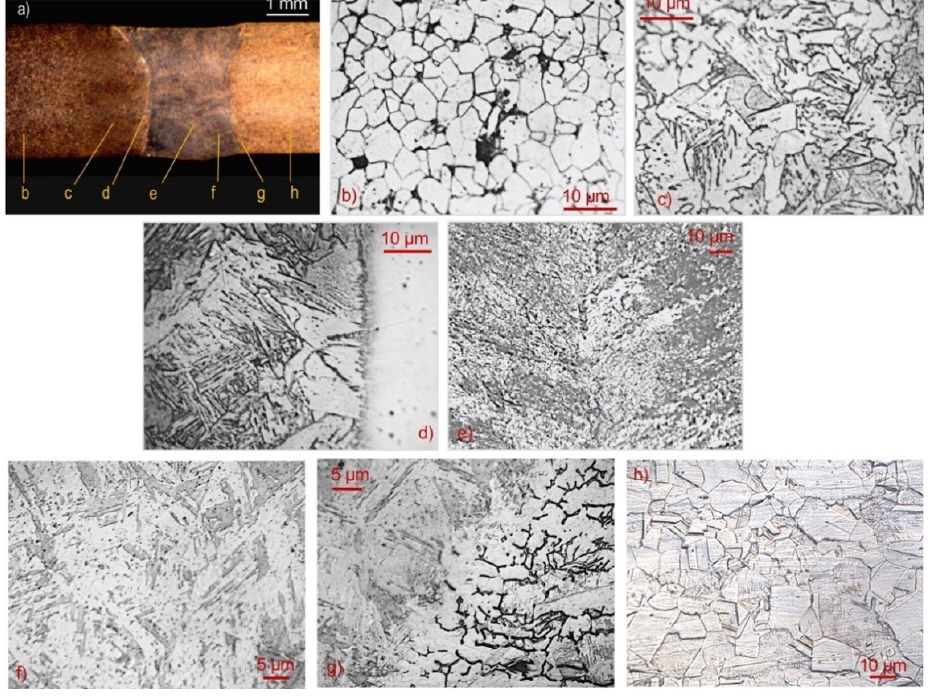
Figure 3. Typical features of the analyzed CS–SS welded joint: ( a ) macrostructure containing indica- tions regarding the positions of the acquired microstructural details; ( b ) as-received CS; ( c ) refined grain region of HAZ on CS side; ( d ) fusion line and coarse grains of HAZ on CS side; ( e ) weld center; ( f ) martensitic structure of the weld; ( g ) fusion line and HAZ on SS side; ( h ) as-received